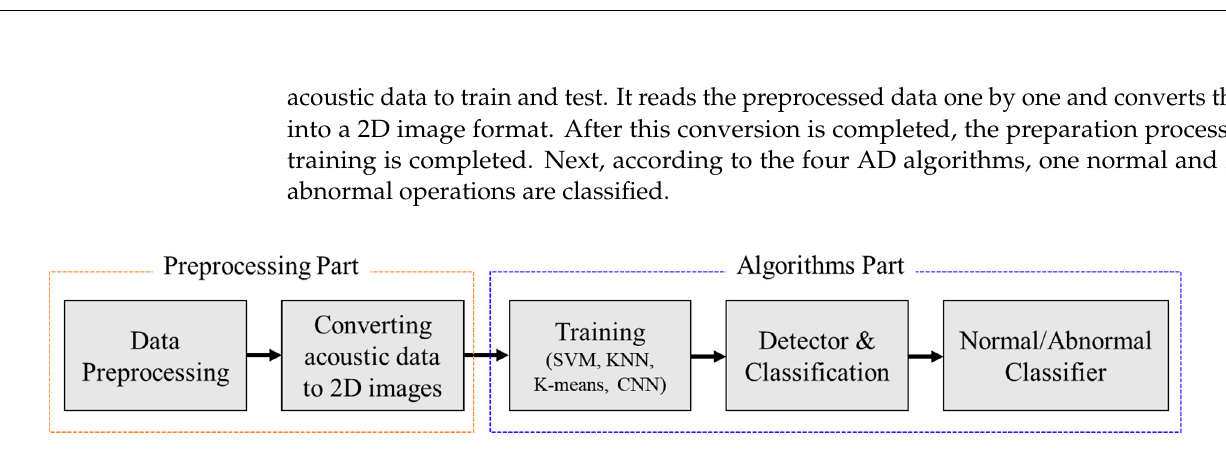
Figure 5. Block diagram of AD models.